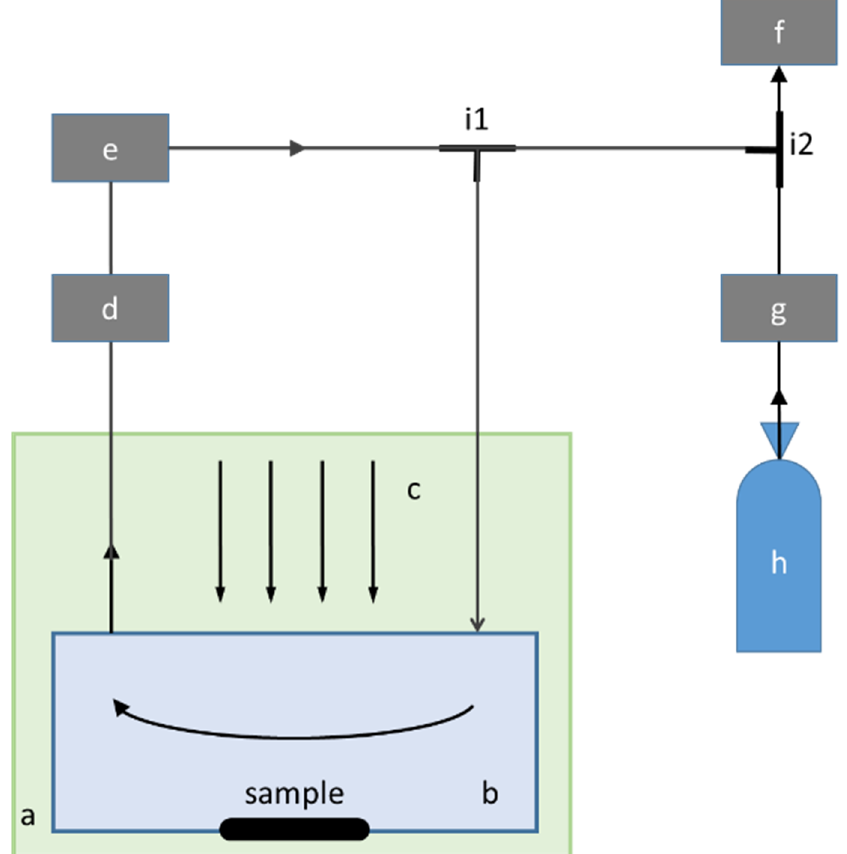
Figure 1. Schematic illustration of gas-phase photocatalysis testing system. ( a ) Thermostatic test chamber, ( b ) PVF pocket, ( c ) light source, ( d ) gas delivery pump, ( e ) gas chromatograph (GC), ( f ) vacuum pump, ( g ) gas mass flow meter, ( h ) toluene gas, and (i1–i2) three-port value. To test the photocatalytic activity, the reaction reactor was first vacuumized by